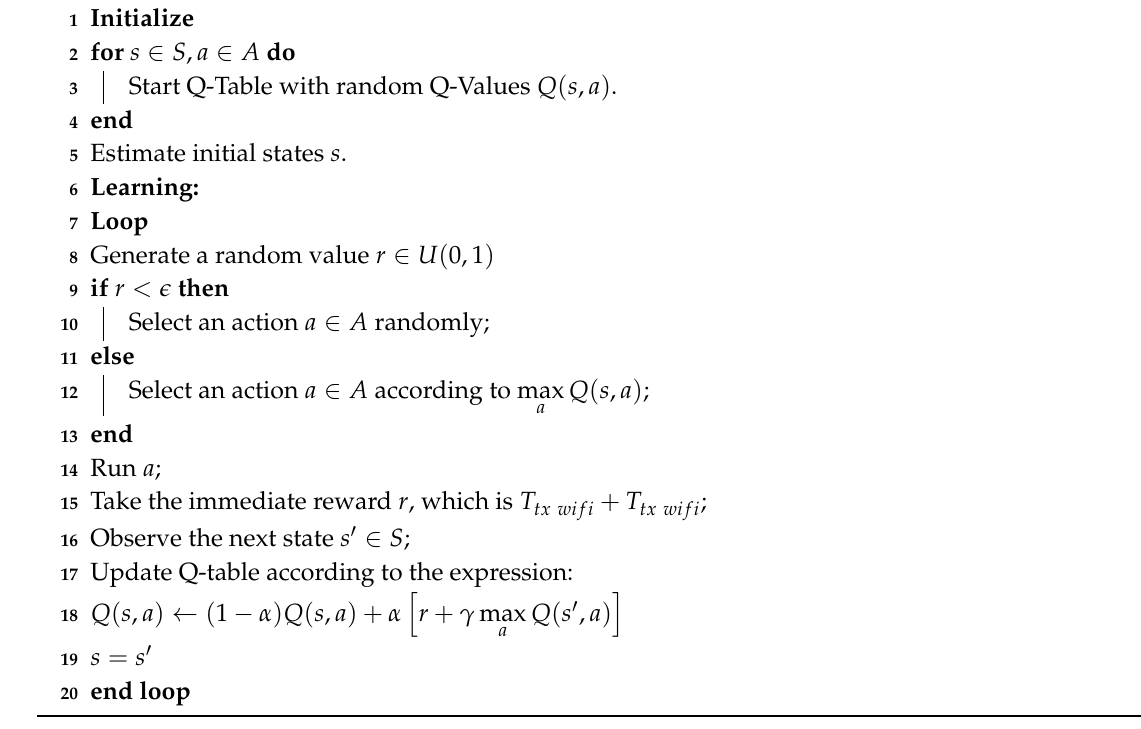
Algorithm 1: Q-Learning application for dynamic duty-cycle selection in a multi-cell